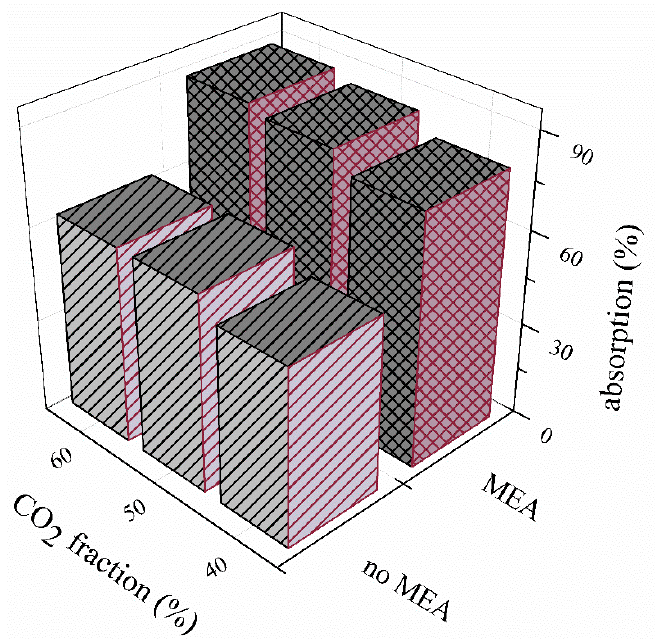
Figure 7. Effect of MEA addition on the %absorption under various CO 2 fractions. Figure 7. E ff ect of MEA addition on the %absorption under various CO 2